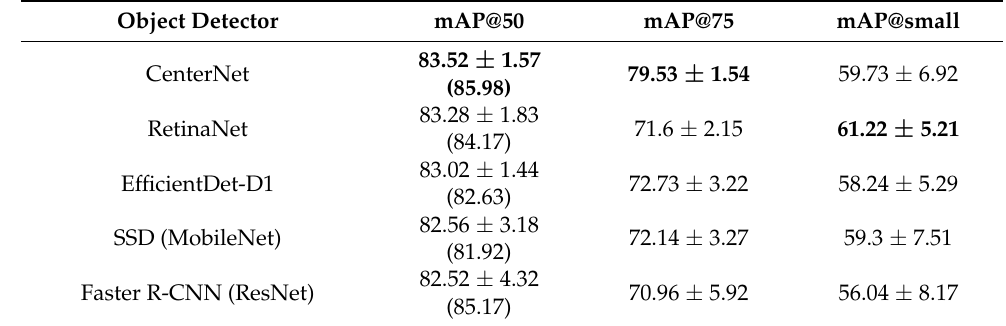
Table 7. The performance of each architecture with both augmentation types (geometrical and colour) active. In the parentheses, the training performance is presented for mAP@50. The bold numbers correspond to the best